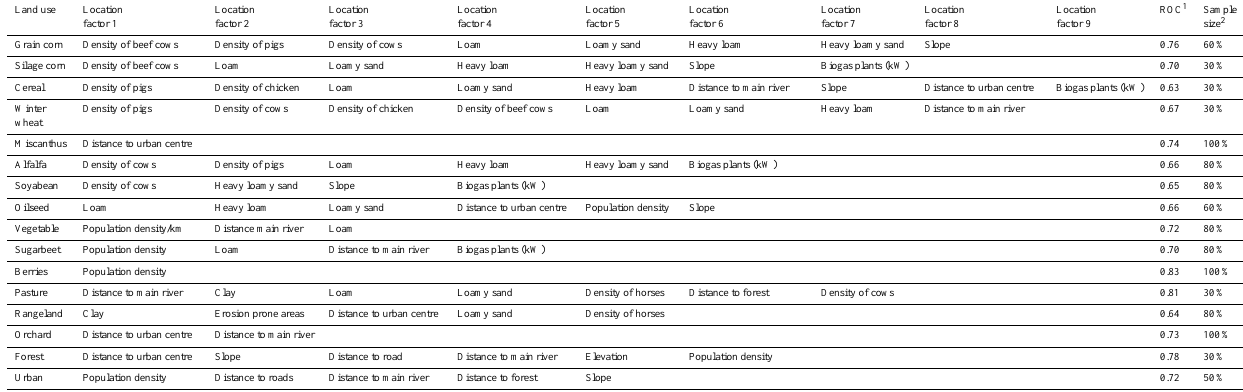
Table 1. Significant local biophysical factors for determining the location of crop types in the upper Altm¨uhl watershed (based on data